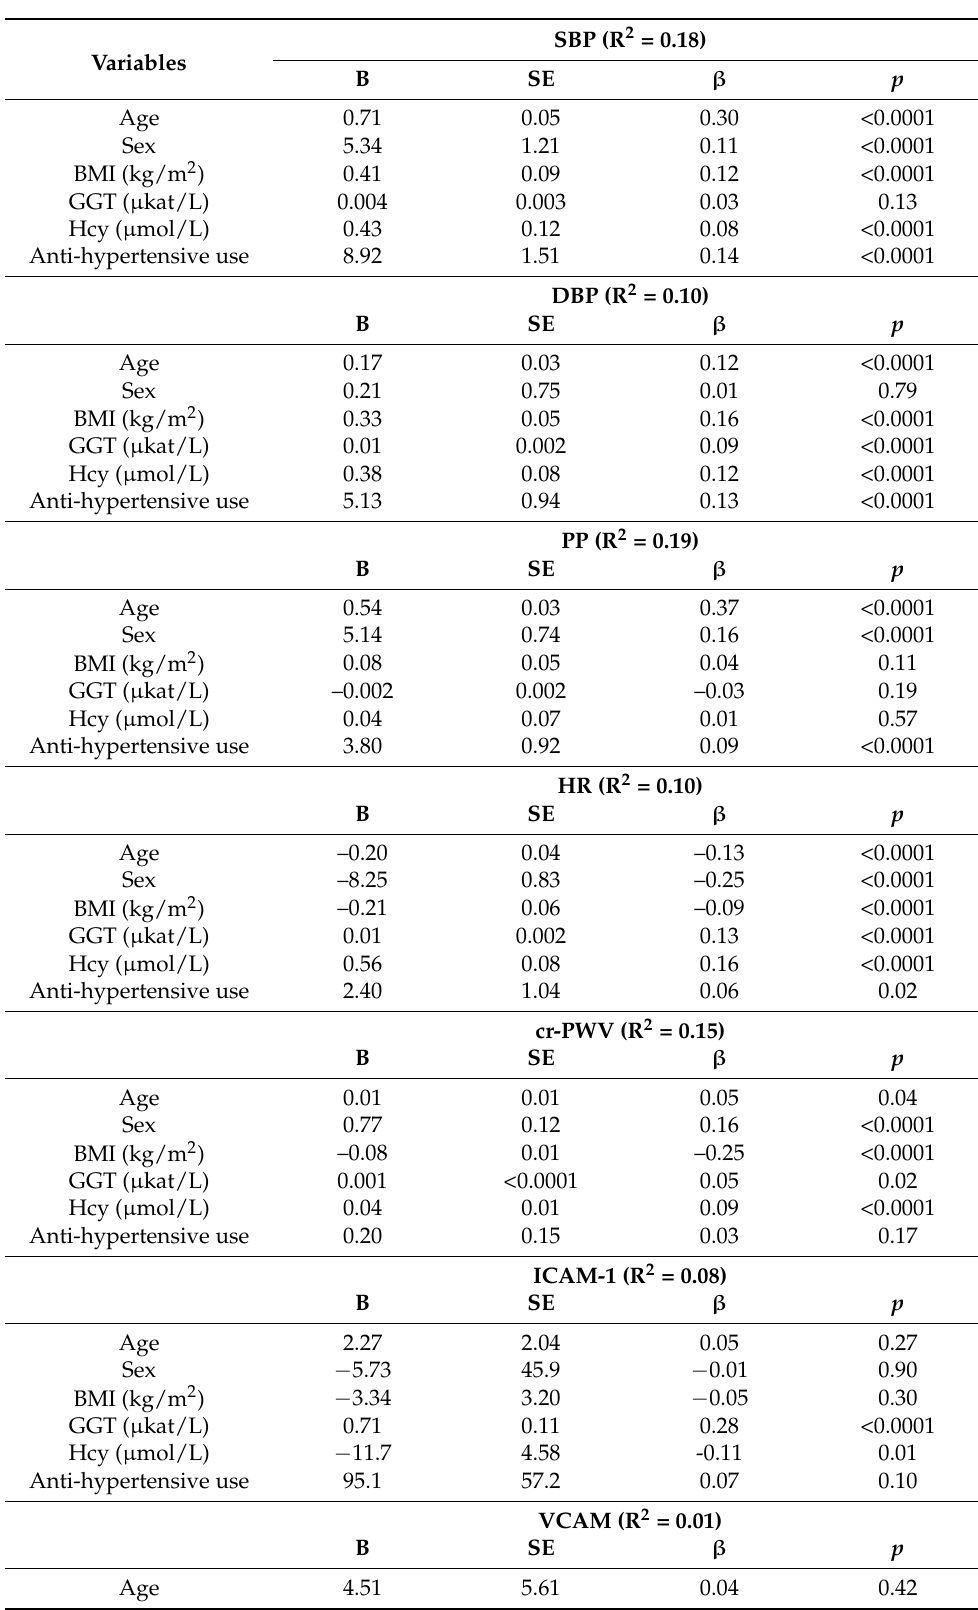
Table 5. Multivariable-adjusted relationships of cardiovascular measures with Hcy.